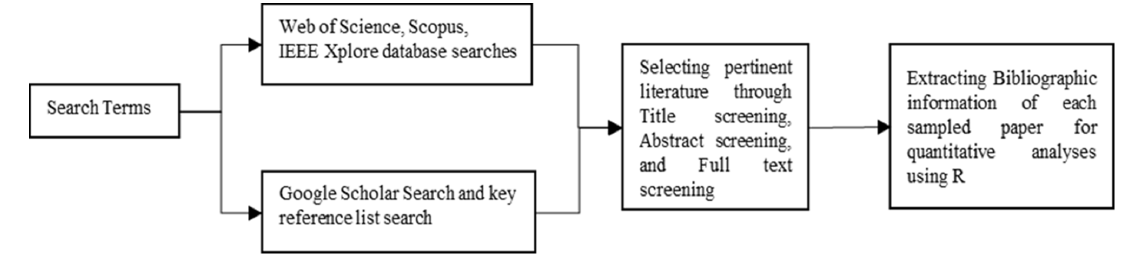
Figure 1. Outline of search strategy.